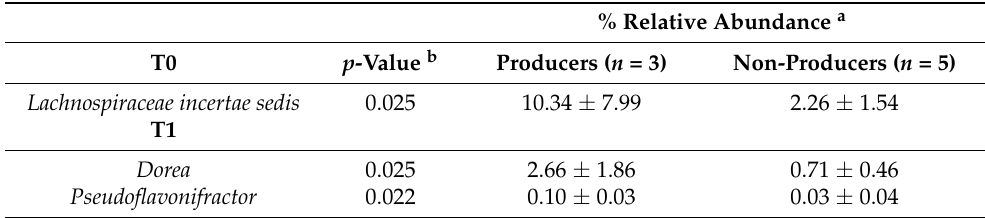
Table 1. Fecal genera showing significant greater relative abundances (% sequences) in equol- producing women before (T0) and after (T1) the soy isoflavone intervention. % Relative Abundance a T0 p -Value b Producers ( n = 3) Non-Producers ( n = 5) Lachnospiraceae incertae sedis 0.025 10.34 ± 7.99 2.26 ± 1.54 T1 Dorea 0.025 2.66 ± 1.86 0.71 ± 0.46 Pseudoflavonifractor 0.022 0.10 ± 0.03 0.03 ± 0.04 a Mean relative abundance ± standard deviation. b Mann–Whitney test.